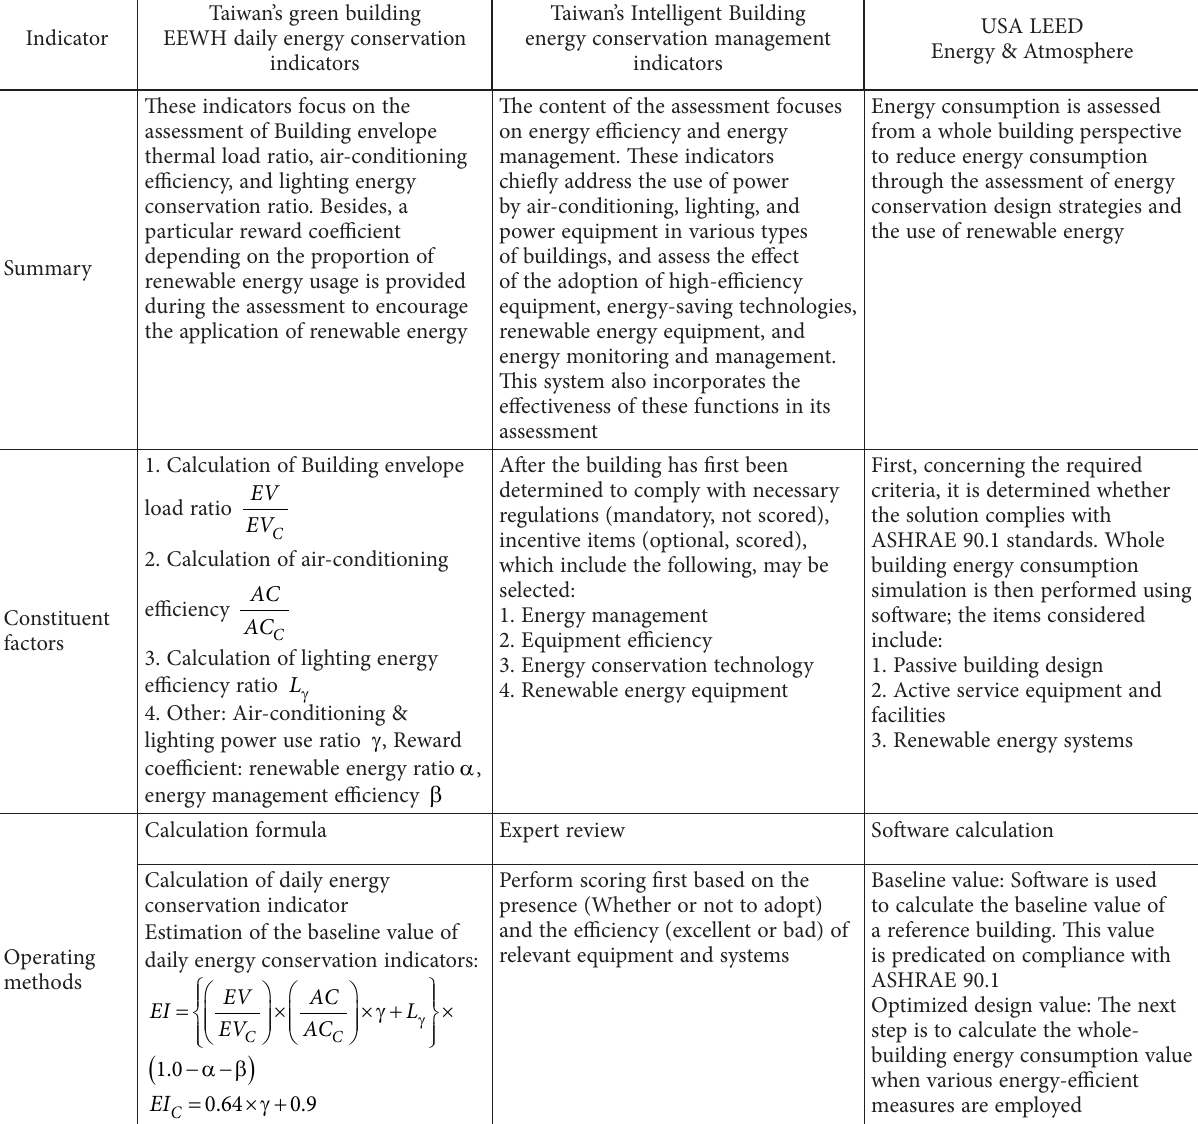
Table 1. Comparison of energy conservation